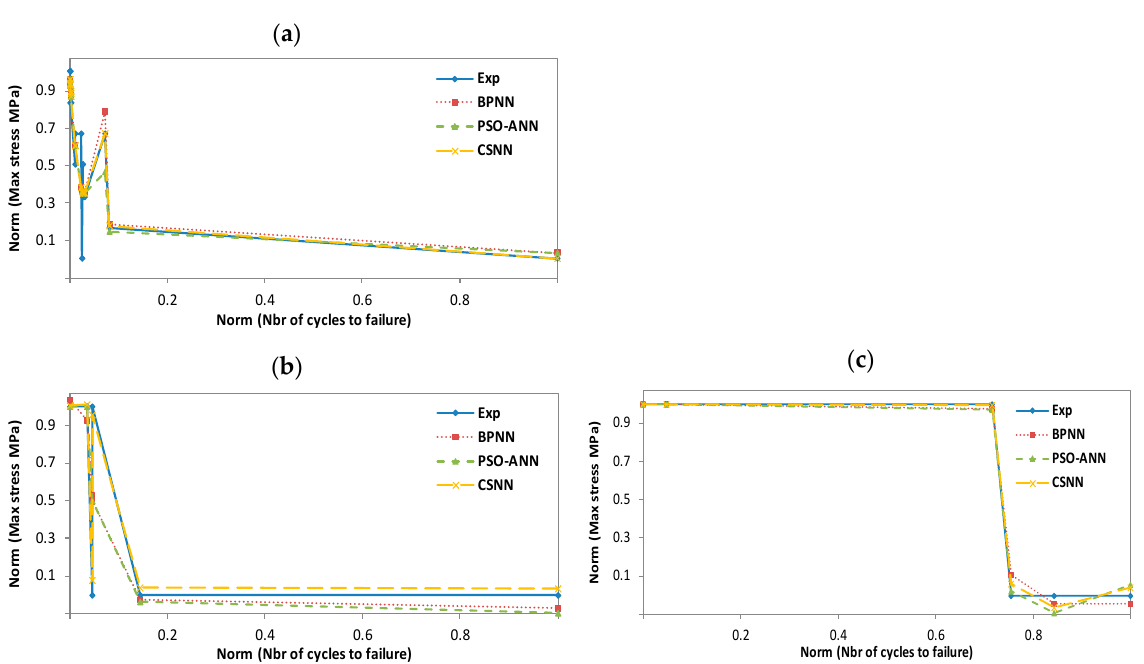
Figure 12. Experimental and predicted values of vinyl ester resin fatigue life (Derakane 8084). ( a ): T = 50 °C wet; ( b ): T = 20 °C dry; ( c ): T = 20 °C wet.